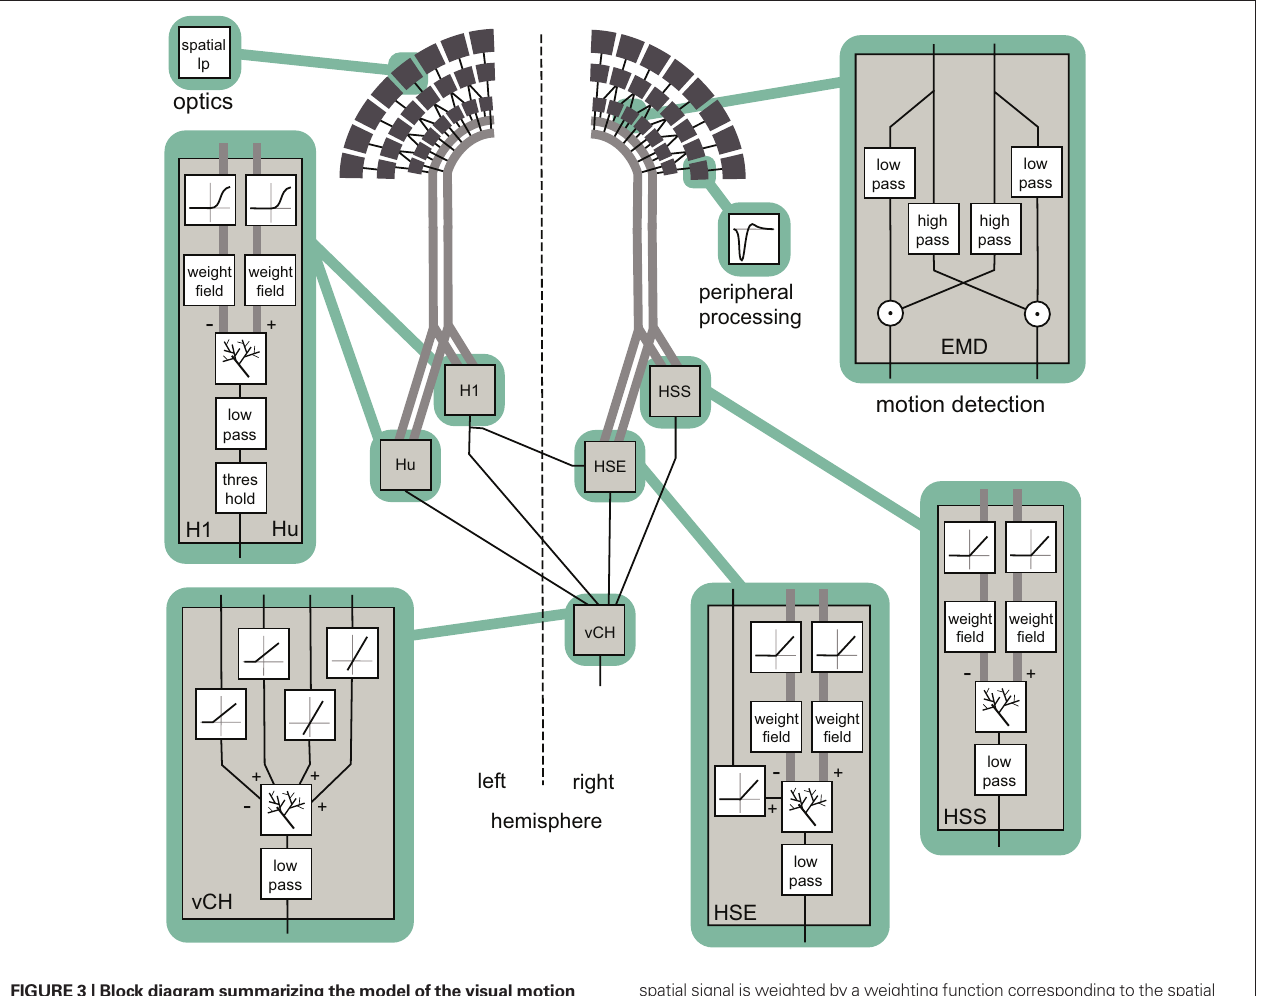
Figure 3 | Block diagram summarizing the model of the visual motion information pathway of the fly from the optics of the eyes to the spatial integration in the lobula plate. A spatial low-pass filter accounts for optic properties of the ommatidia. The peripheral processing is approximated by an array of temporal band-pass filters (indicated by the impulse function of the filter) providing the input to an array of elementary motion detectors (EMD) sensitive to horizontal motion. Each EMD is subdivided into two mirror symmetric subunits with opposite preferred directions, each consisting of a temporal high-pass, a low-pass filter, and a multiplication stage. The retinotopic motion information of the half-detectors with the same preferred direction is bundled up in one channel (broad gray lines). The motion information conveyed by the channels is spatially integrated by model cells presynaptic to the vCH-cell. Synaptic transmission is characterized by a half-wave rectification before the